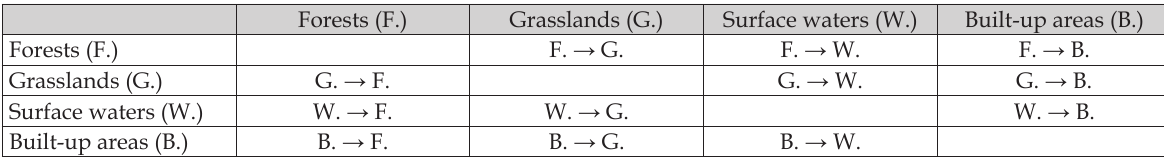
Table 2. Potential possibilities of transformation of the land cover options considered. Forests (F.) Grasslands (G.) Surface waters